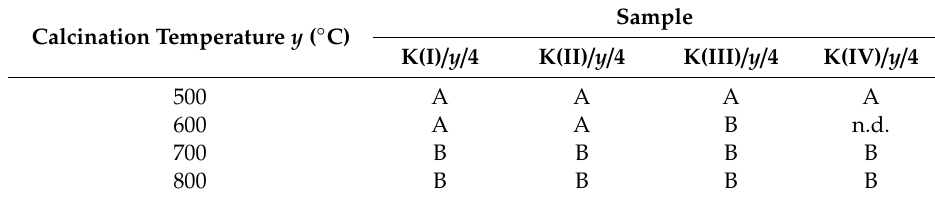
Table 3. K-containing phases detected by XRD in Co–Mn–Al mixed oxide with di ff erent K-content and calcined at di ff erent temperatures (fresh